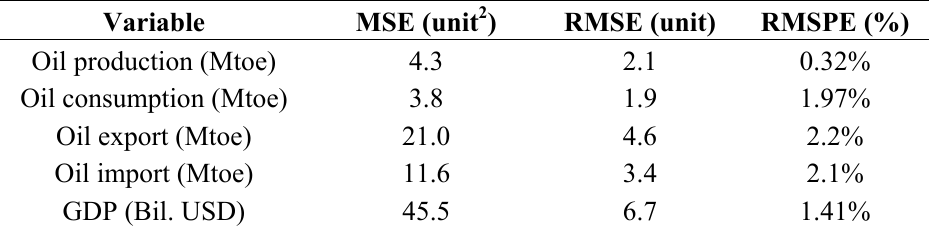
Table 3. Error analysis of critical